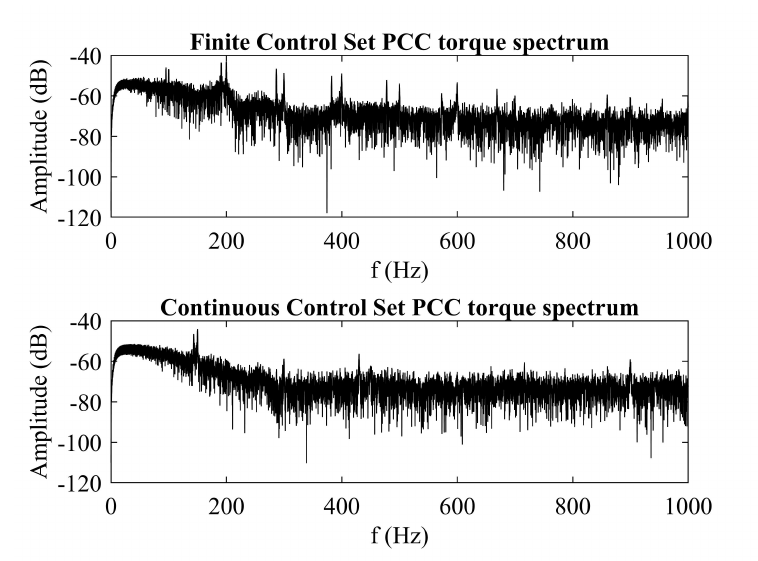
Figure 10. Fourier analysis of torque for continuous and finite control set PCC